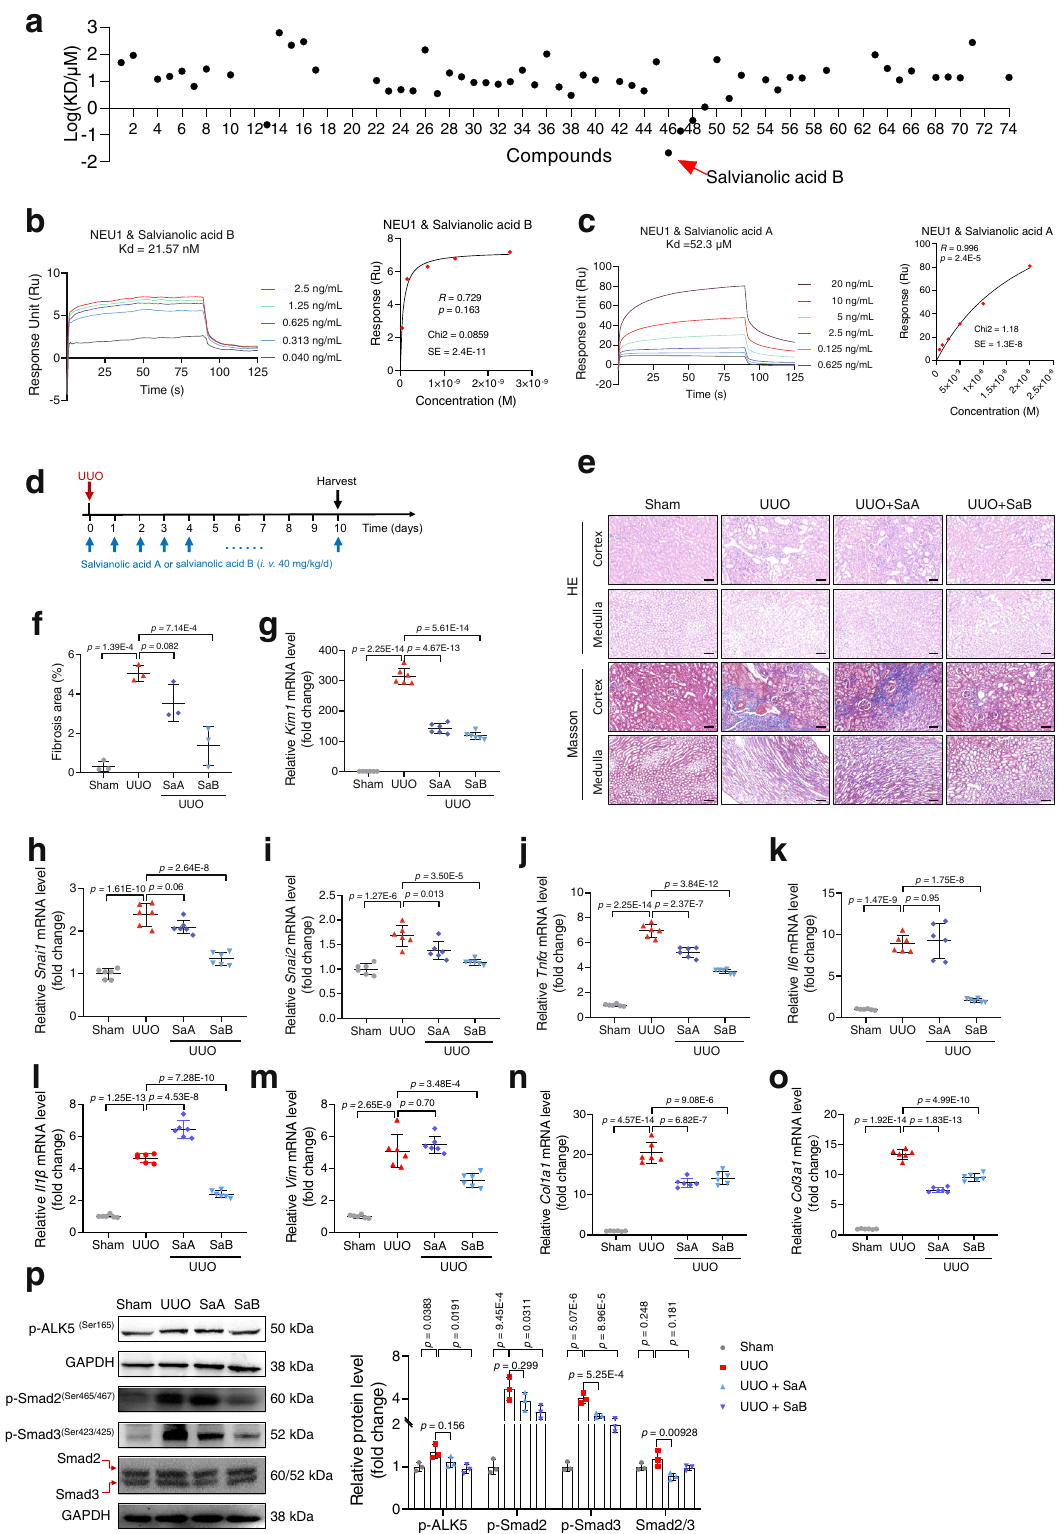
and4 =75%ormorein fl ammatorycellin fi